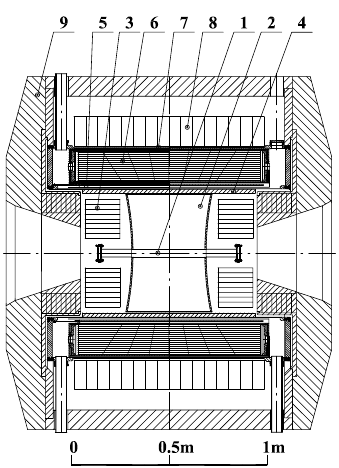
Figure 1. CMD-3 detector: 1 – beam pipe, 2 Figure 2. Statistical precision of | F